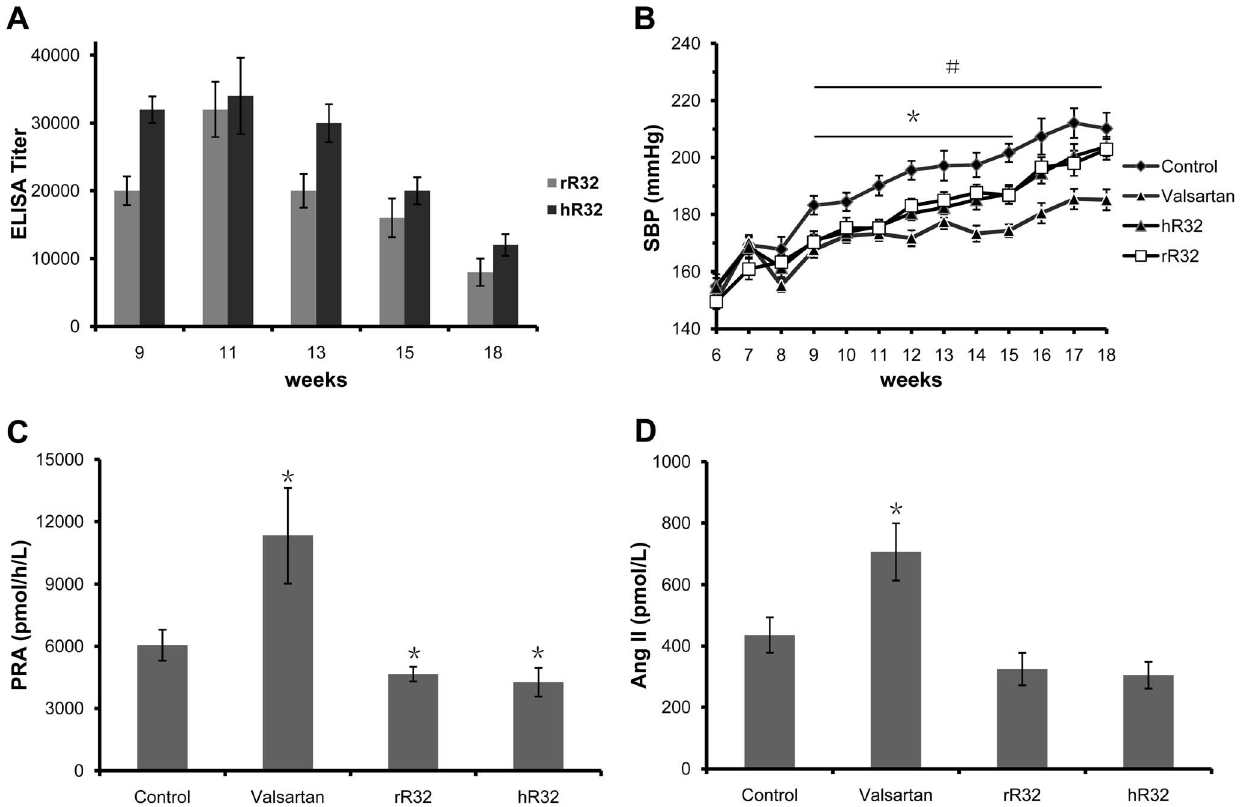
Figure 4. Both vaccines of rR32 and hR32 decreased SBP and PRA of SHRs. A. The antibody titers of the rR32 and hR32 vaccines. B. The rR32 and hR32 vaccines significantly decreased SBP of SHRs compared with the KLH immunization group. During the whole experiment, SBP of the valsartan group was significantly lower than that of the control group. C. On week 12, the PRA of the rR32 and hR32 groups was decreased compared with the control group, while the PRA of the valsartan group was increased. D. Ang II concentration in the vaccine groups tend to be lower than that of the control group, but no significance was observed. The Ang II concentration in the valsartan group was increased. * P , 0.05 presents the vaccines groups vs the control group, and # P , 0.01 presents the valsartan group vs the control group.